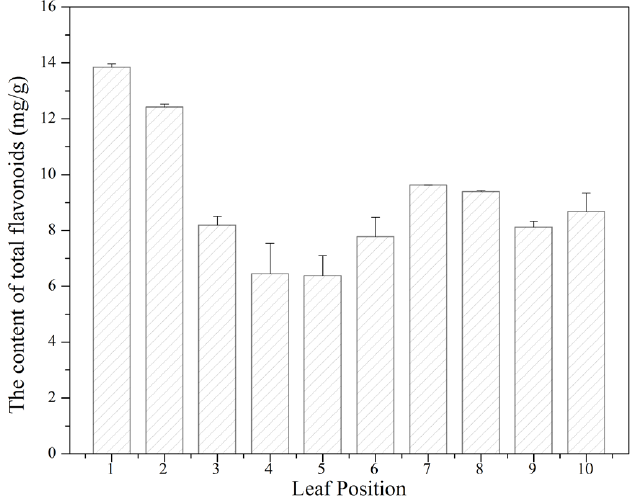
Tab. 4: Total flavonoids in 86 varieties of mulberry leaves Mulberry